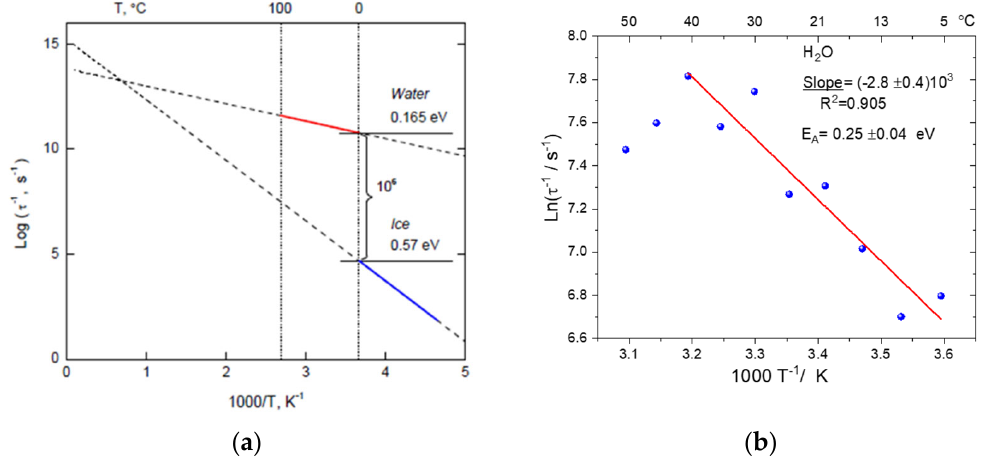
Figure 5. ( a ) The Arrhenius plot for the inverse relaxation times of water and ice, showing the corresponding activation energies, reprinted with permission from Ref. [35]. ( b ) The Arrhenius plot for the inverse of the R 2 C 2 time constant of mortar specimens, reconstructed from data in [30].